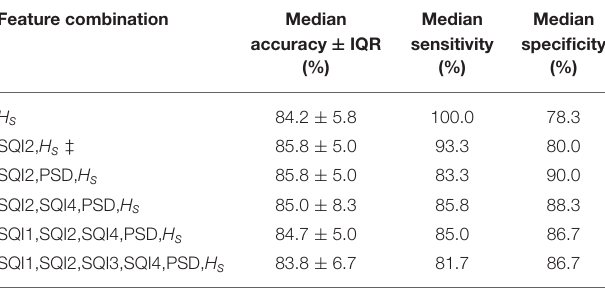
TABLE 1 | Median classification performance of the 100 five-fold cross validation balanced with bootstrapping. Feature combination